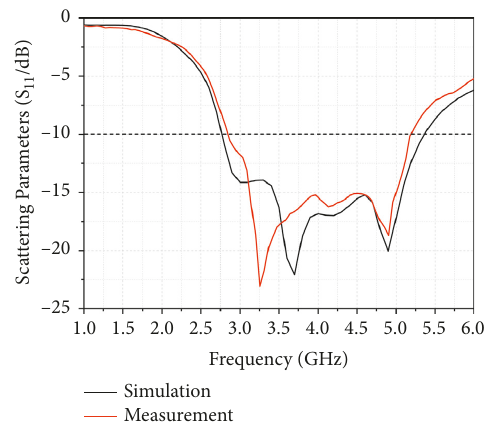
Figure 14: Reflection coefficient of the proposed antenna.